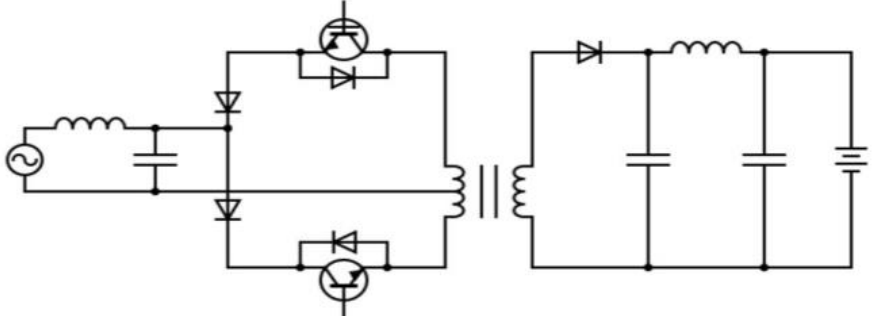
Figure 8. Bridgeless positive output Luo converter [18].